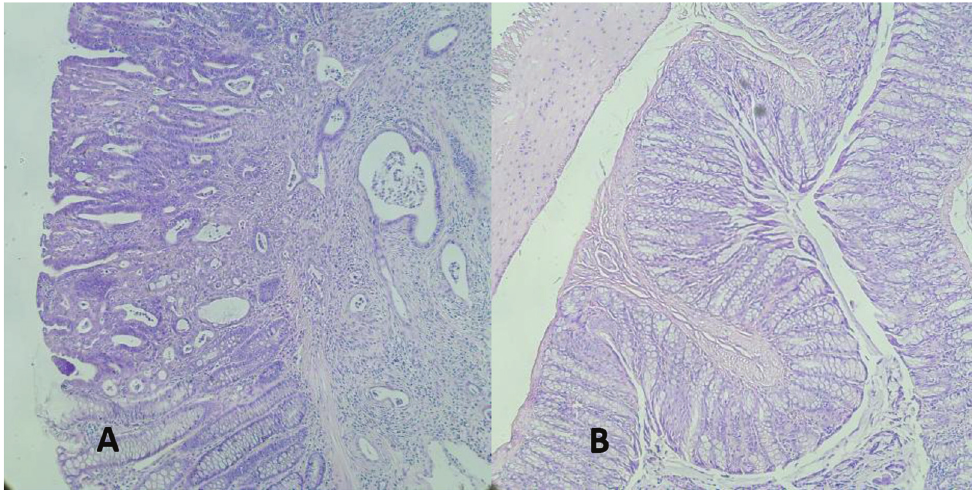
Figure 1 - Histological analysis of (A) DMH-induced rat colonic adenoma and (B) normal tissue. Magnification: x 20; Hematoxylin-eosin